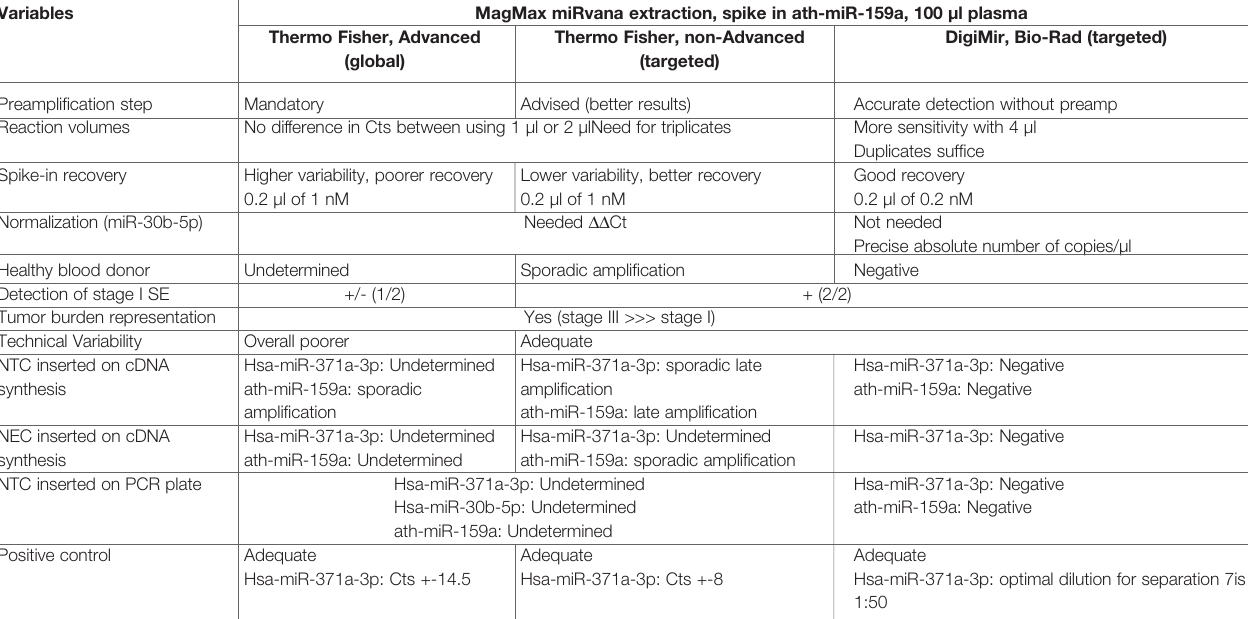
TABLE 2 | Summary of the three different pipelines for comparing hsa-miR-371a-3p.